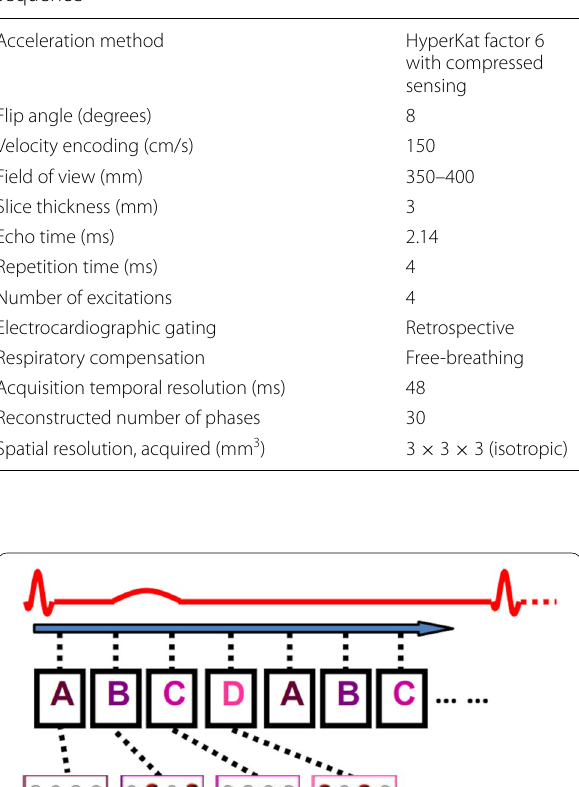
Table 1 Technical parameters of the four‑dimensional flow sequence